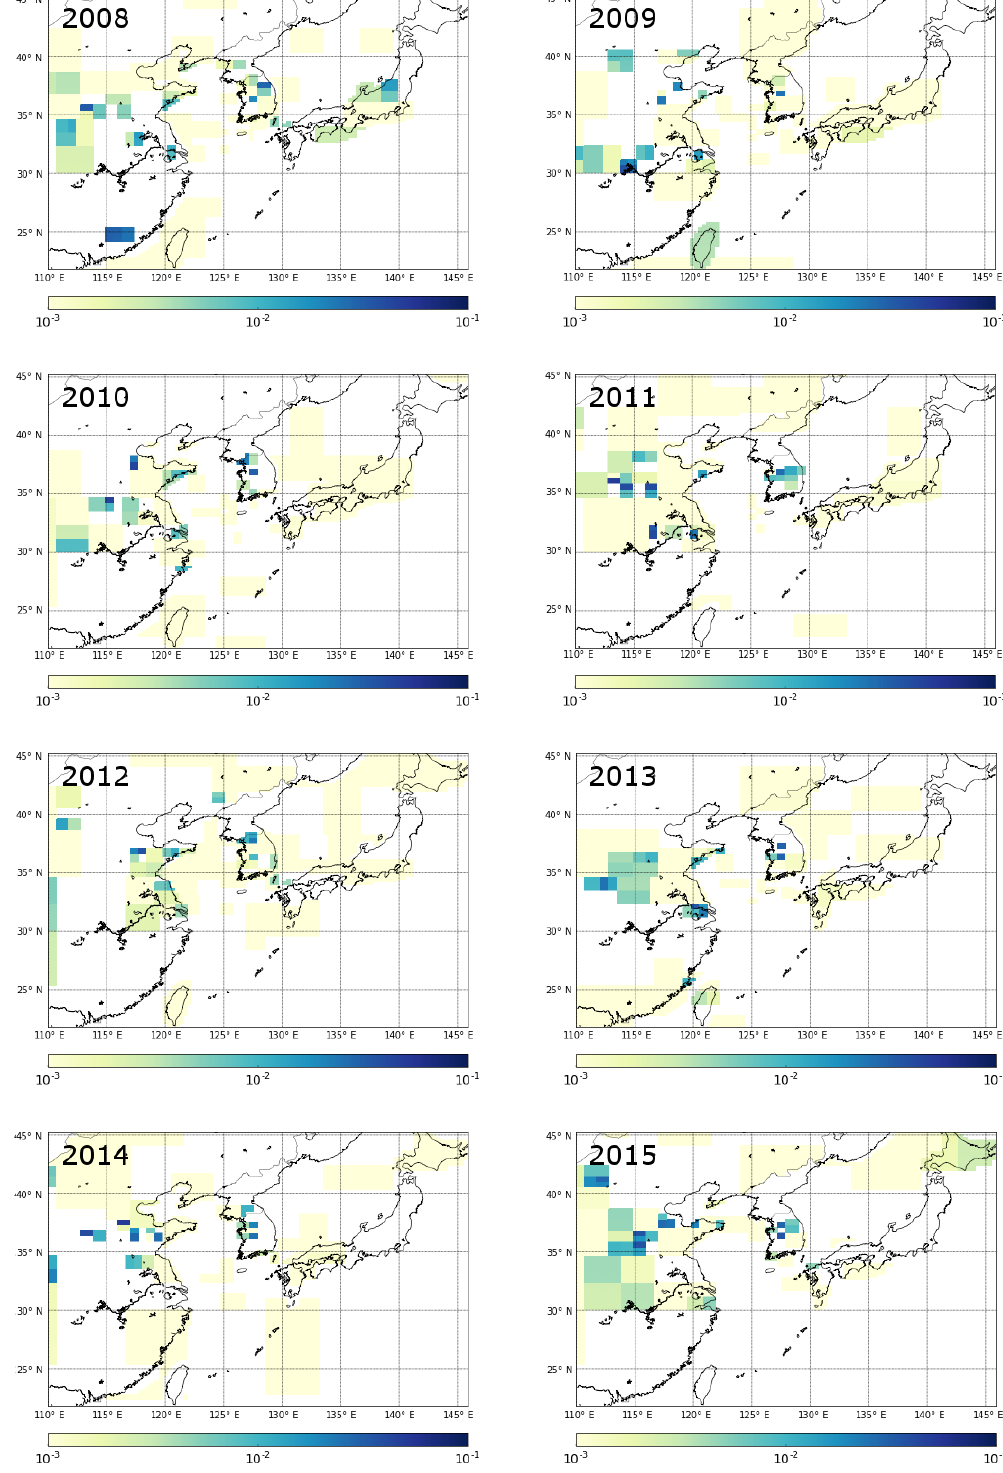
Figure 6. Emission maps for all years of data available for CF 4 . Results are from inversions with initial uncertainty on the prior emission field set to 100 times the emissions at each fine grid square. Units are in gm − 2 yr − 1 ; see Fig. S7 for corresponding maps of emission magnitude minus the